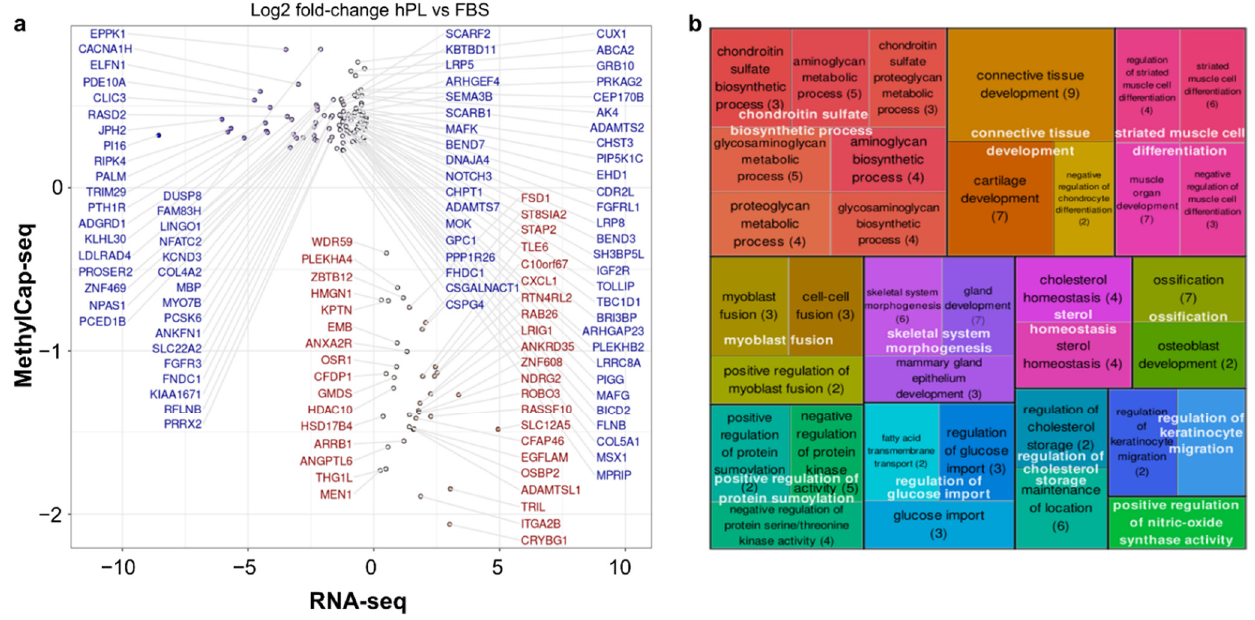
Figure A5. Overlap between RNA-seq and MethylCap-seq. ( a ) Genes found significantly upregulated and hypomethylated in hPL vs. FBS (red labels) or downregulated and hypermethylated in hPL vs. FBS (blue labels). X axis shows the log2-fold changes for RNA-seq. Y axis shows log 2-fold methylation changes. ( b ) Gene ontology (GO) enrichment analysis showing significant biological processes enriched for genes found downregulated and hypermethylated in hPL vs. FBS (blue labelled genes, in a) (adjusted p -value < 0.05, Benjamini–Hochberg multiple testing correction). Similar GO categories are clustered together and labelled based on semantic similarity. The size of boxes is related to the number of genes in the respective category.